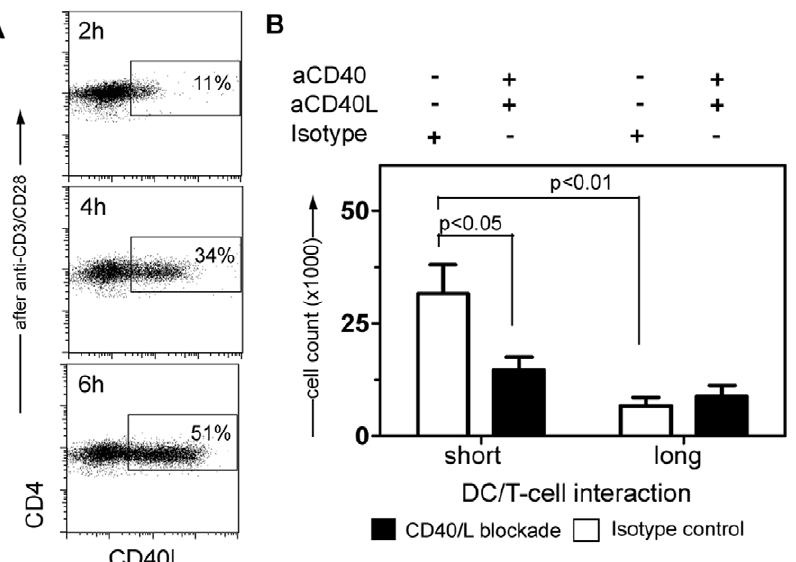
Figure 4. Blockade of CD40/CD40L signaling in short- versus long-term DC/T-cell Co-cultures. (A) CD40L expression on CD4 + T-cells activated after 2, 4 and 6 hours of CD3/CD28 cross-linking is shown. One representative out of 4 experiments is depicted. (B) Short- or long-term co- culture of CD3 + T-cells and DCs, activated with LPS/IFN- c for 6 hours, in the presence of blocking CD40 and CD40L monoclonal antibodies (black bars) or isotype control immunoglobulins (white bars) is shown. Median 6 SEM of 7 to 12 experiments is depicted. DCs from Donors A, B and D were used in experiments (A) and (B).